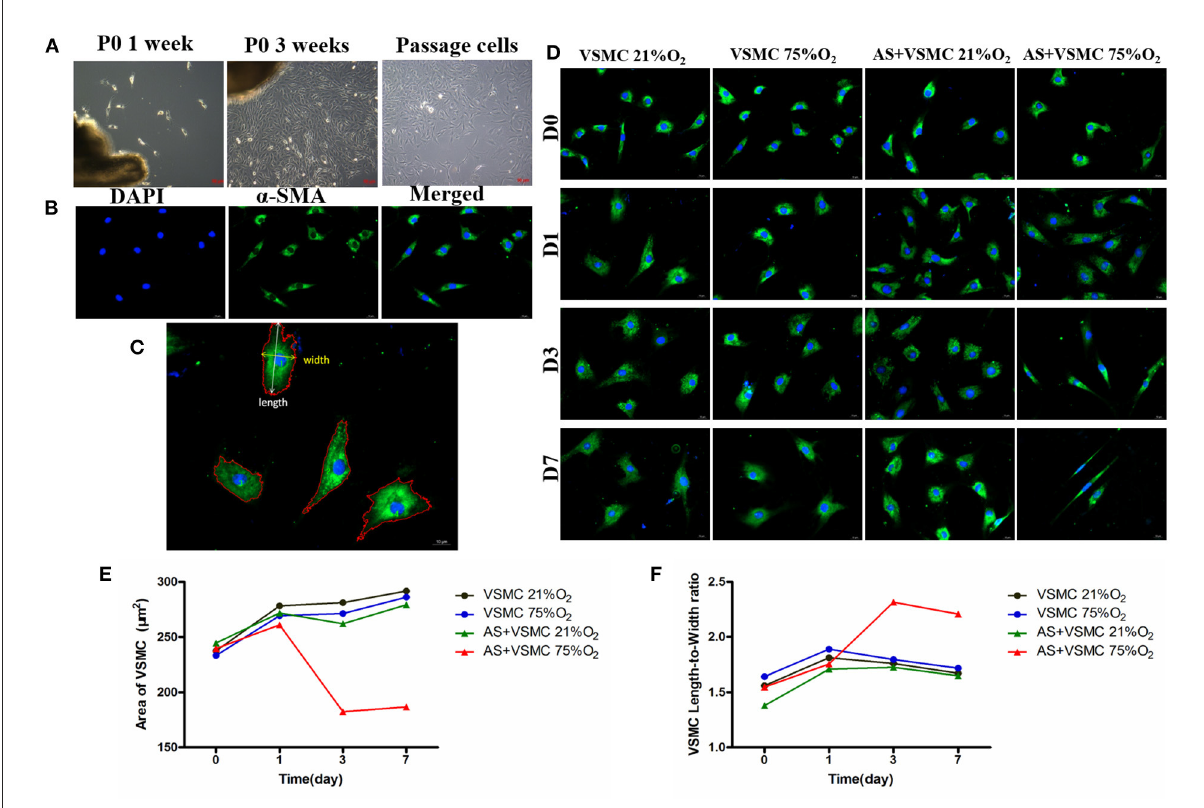
FIGURE8 Isolation and identification of VSMCs and contraction of VSMCs in direct co-culture systems induced by hyperoxia. (A) Primary VSMCs grew out of the explants within 1 week, and reached confluence in about 3 weeks. Passaged VSMCs grew as a “hill and valley” pattern. (B) VSMCs showed positive staining for α -SMA. (C) The area, length and width of α -SMA-positive cells were analyzed. (D) Morphology of VSMCs in different culture conditions. (E) Area of VSMCs significantly decreased in co-culture systems after hyperoxia exposure for 3 days and 7 days. (F) VSMCs length-to-width ratio significantly increased in co-culture systems after hyperoxia exposure for 3 and 7 days. VSMCs, Vascular smooth muscle cells; α -SMA, alpha-smooth muscle